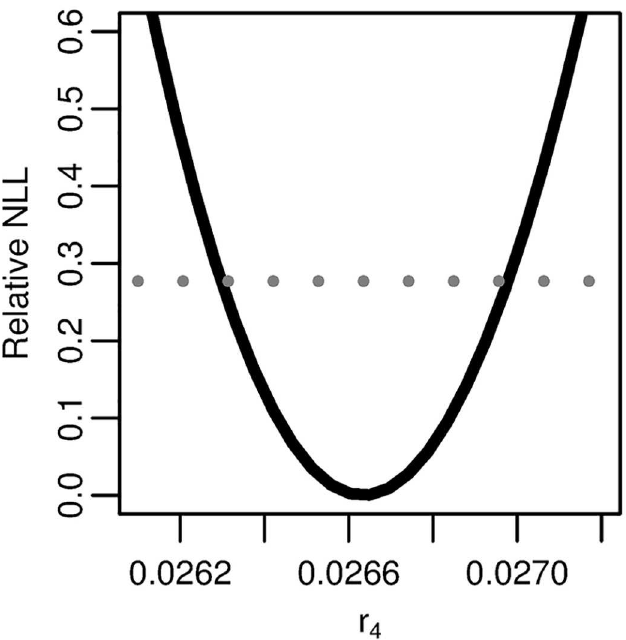
Fig 10. Profile likelihood for the reparameterized combination of the four-stage model. Profile of the relativenegative log-likelihood (NLL) as the parameter r 4 = ( ν X μ 1 μ 2 / α ) 1/3 is variedwhile the remaining parameters are fit in the four stage clonal expansionmodel. The gray dotted line gives the α = 0.01 threshold for simultaneous confidenceintervals basedon the relative negativelog-likelihood. Parameter combination r 4 is